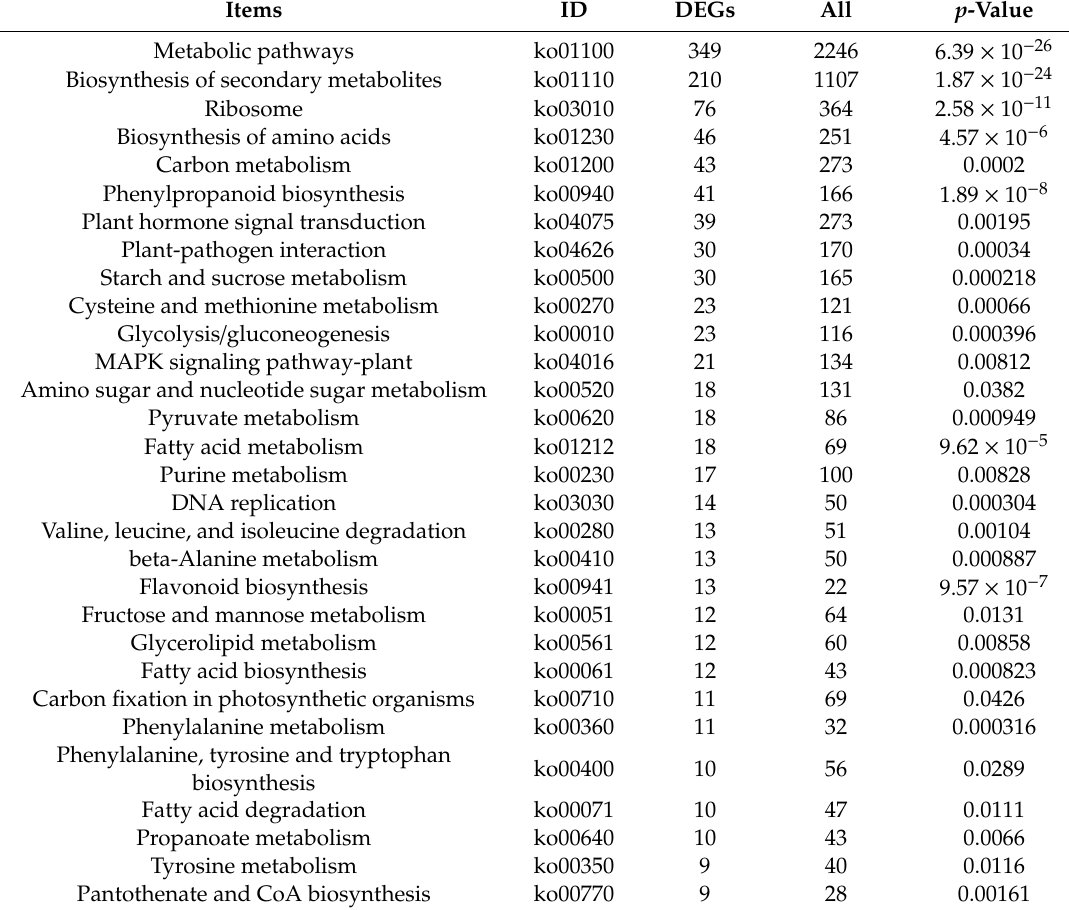
Table A3. Pathway enrichment analysis in DEGs ( p -value ≤